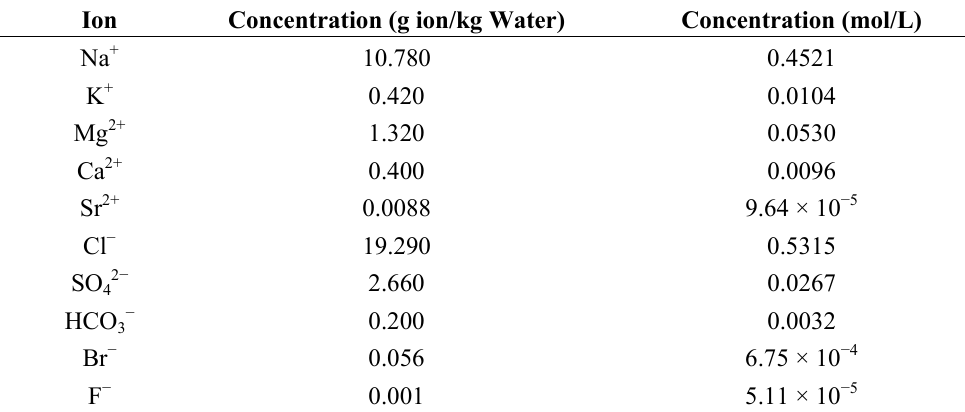
Table 1. Chemical composition and ion concentration in Instant Ocean ® synthetic sea